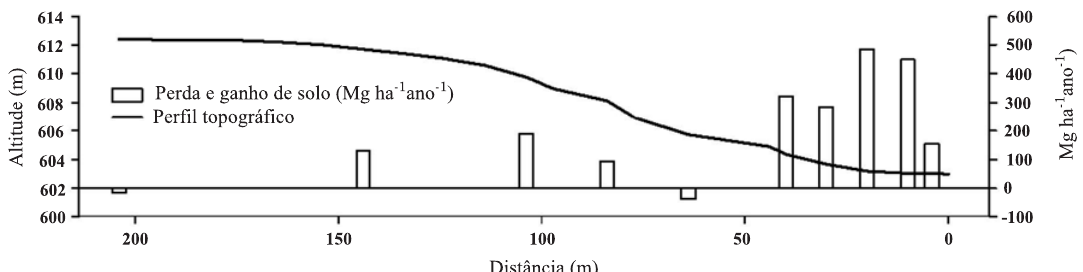
Figura 2. Perfil topográfico com uso do solo, taxa de erosão (Mg ha -1 ano -1 ) e análise detalhada da atividade de 137 Cs nas trincheiras abertas na área de mata ciliar na